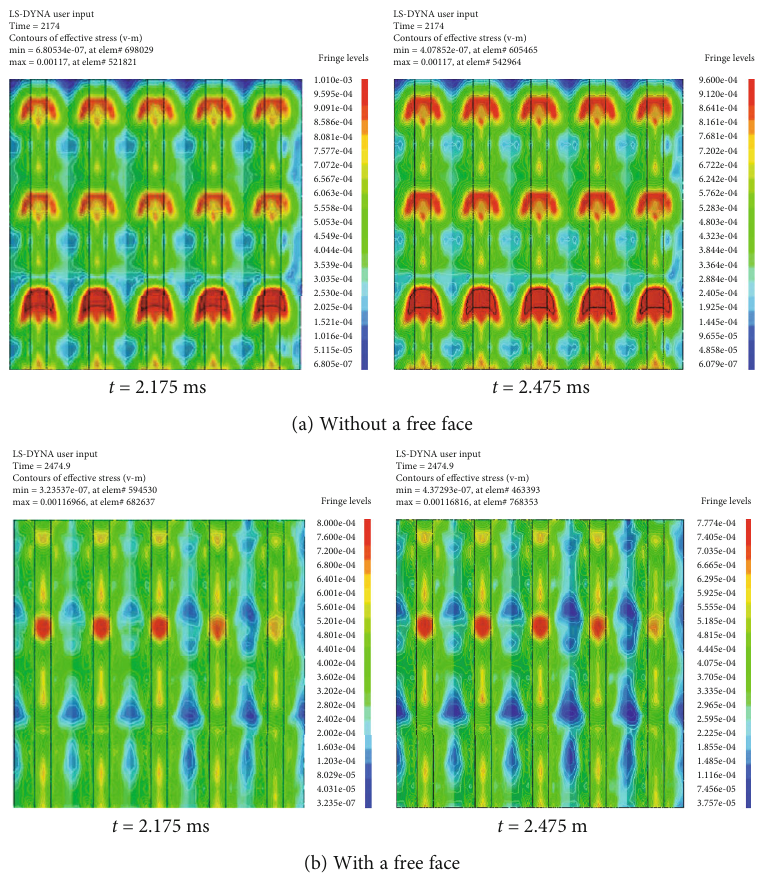
Figure 21: E ff ective stress cloud images of the cross section B-B in the